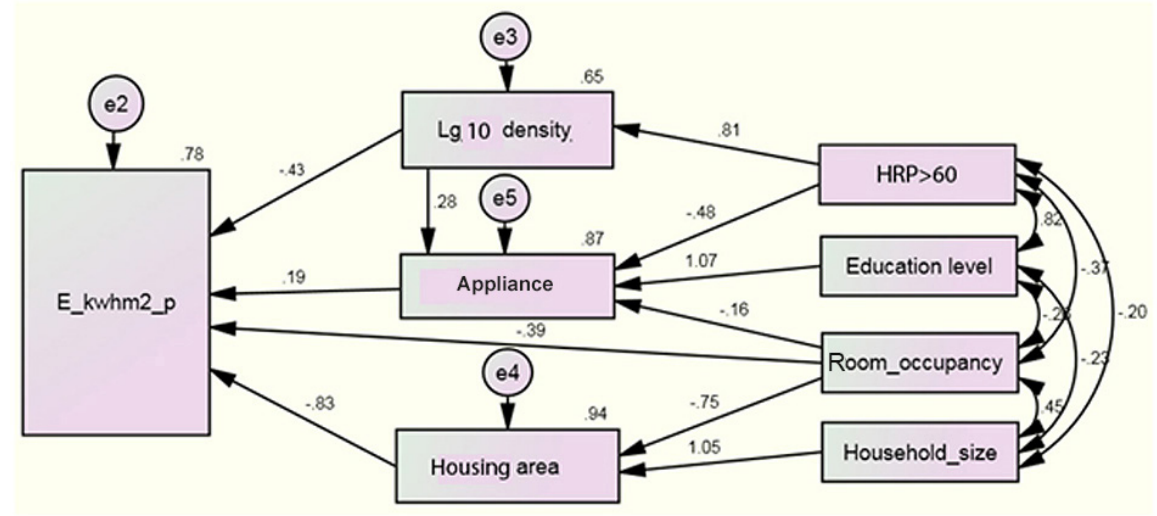
fig. 11. Direct impact of variables on per-capita